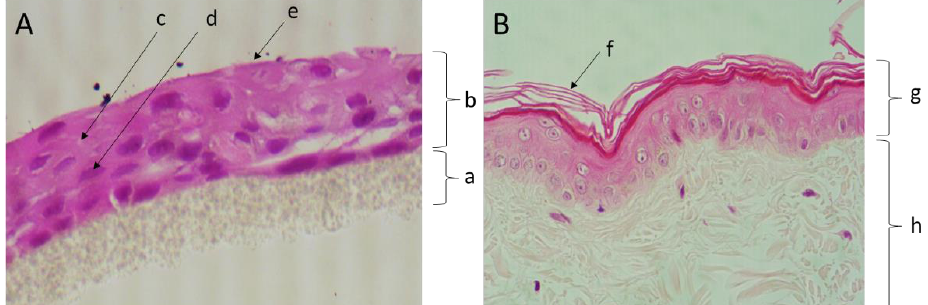
Figure 2. Micrographs of a section of the canine epidermis-like culture ( A ) and a canine skin biopsy ( B ), both routinely processed and stained with hematoxylin and eosin (400× amplification). Legend: (a) insert porous membrane; (b) keratinocyte layers of the histotypical culture; (c) cell junctions; (d) keratinocyte nucleus; (e) stratum corneum-like layer; (f) stratum corneum; (g) epidermis; (h) dermis.